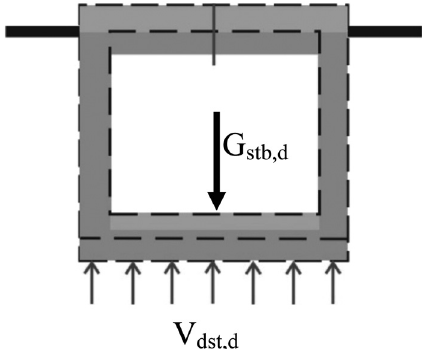
Figure 1: Diagram of the limit state of displacement of the building structure: V dst,d – vertical destabilizing permanent and variable interactions, G stb;d – vertical stabilizing permanent interactions [ 13